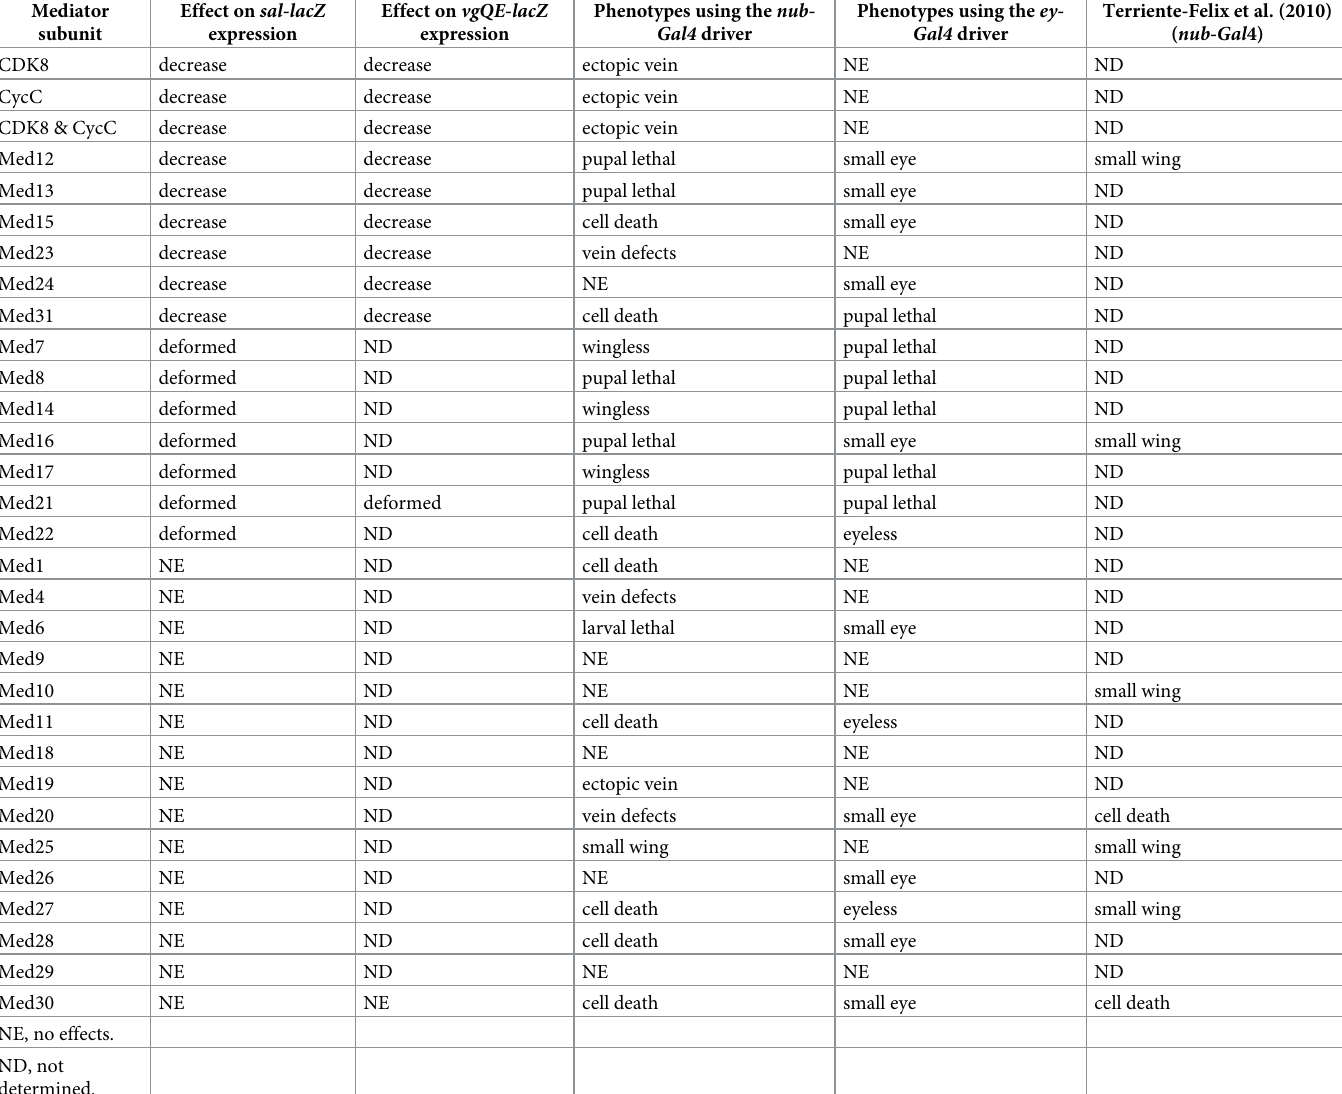
Table 3. The effects of depleting different Mediator subunits on the expression of the sal-lacZ and vgQE-lacZ reporters in wing discs during the third instar larval stage, as well as the wing and eye phenotypes in adult flies. Mediator Effect on sal-lacZ subunit